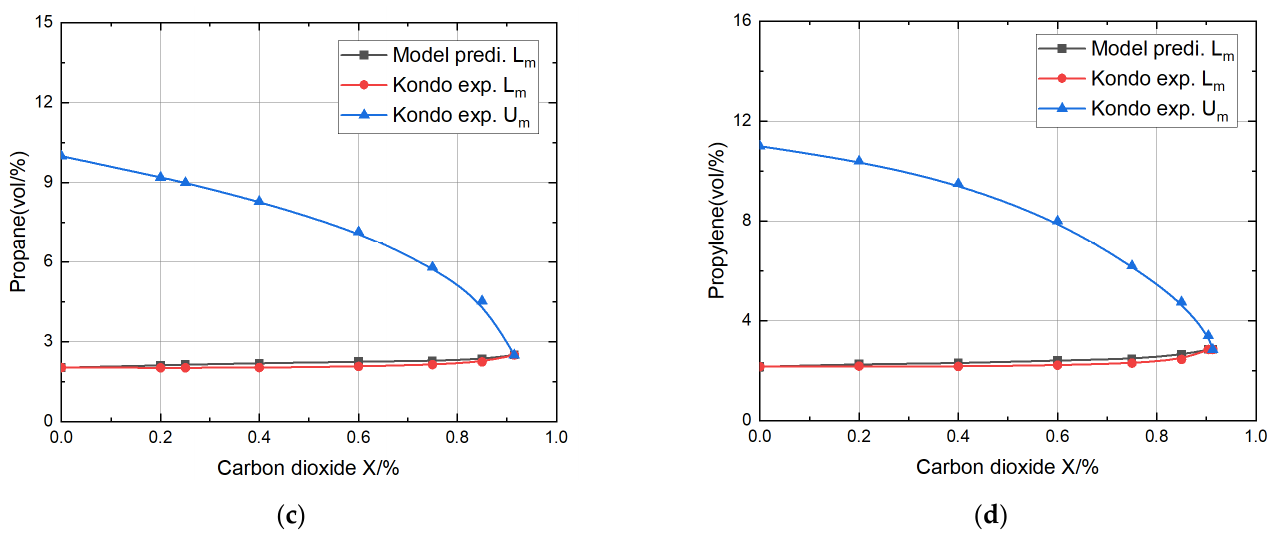
Figure 2. Standard flammability diagrams of methane, ethylene, propane and propylene mixed with carbon dioxide. Calculation of the explosion limit of ( a ) “methane + carbon dioxide”; ( b ) “ethylene + carbon dioxide”; ( c ) “propane + carbon dioxide”; ( d ) “propylene + carbon dioxide”.